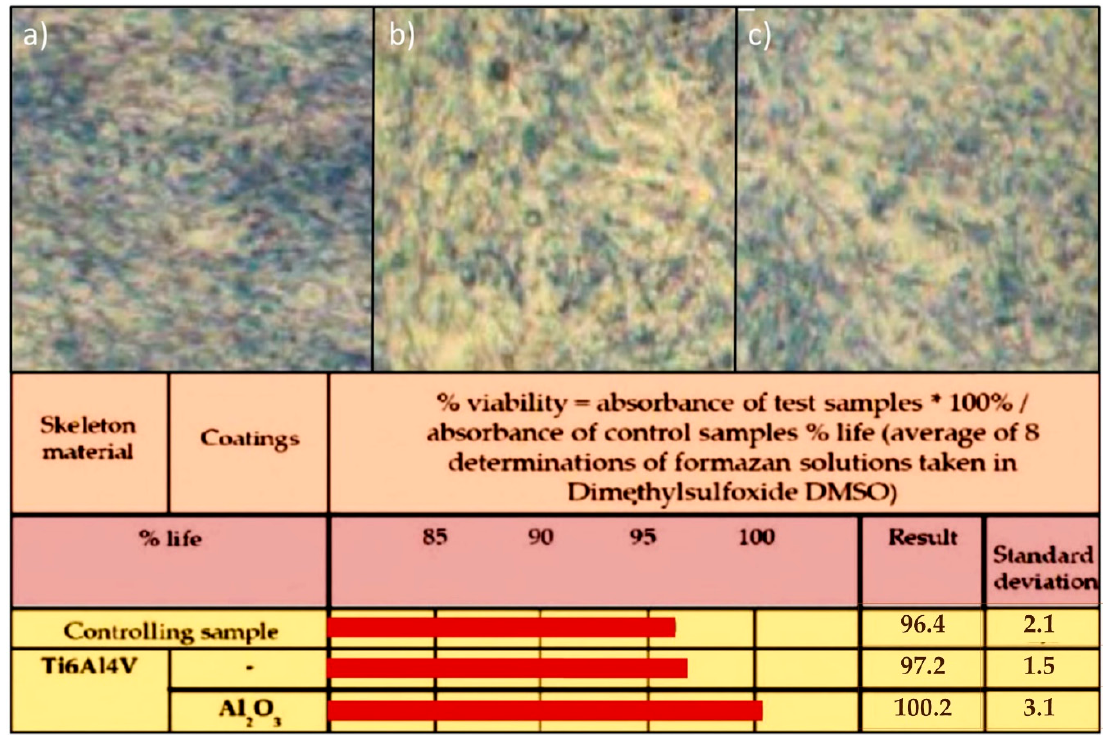
Figure 32. Images of specimen surfaces (light microscope, fluorescent contrast); ( a ) control glassware; ( b ) Ti 6 Al 4 V alloy without surface layer; ( c ) Ti 6 Al 4 V alloy with Al 2 O 3 coating applied by the ALD method.